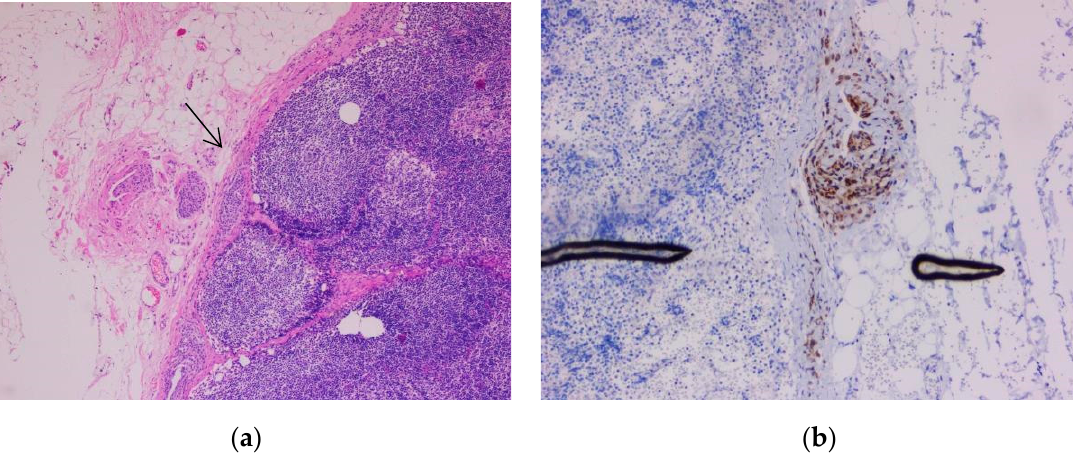
Figure 13. Capsular nevus. ( a ) Melanocyte proliferation in the lymph node capsule. The cells were round or ovoidal in shape, with eosinophilic cytoplasm and round nuclei located in the center of the cell, 5× magnification (arrow). ( b ) Cytoplasmic immunostaining with marker Melan-A showing the melanocytic cells aligned in the lymph node capsule (10× magnification). (Collection of Pathology Department SCJ Mure ș ).